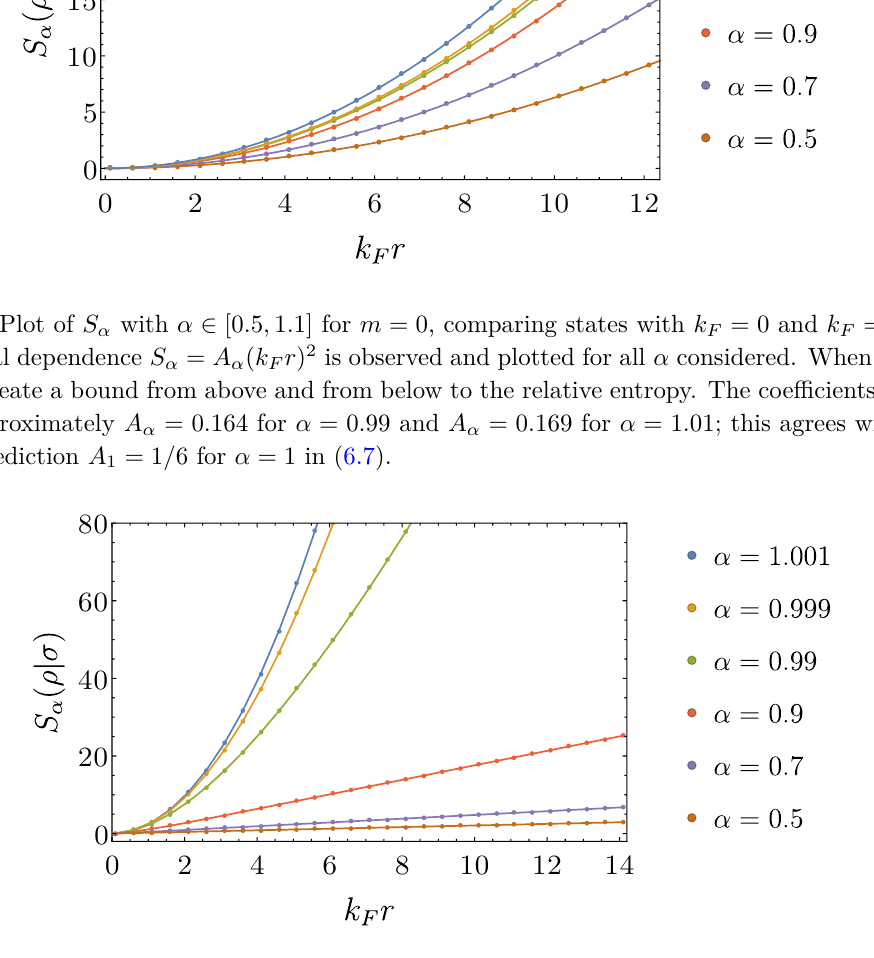
Figure 10 . Plot for the relative Renyi entropies with α ∈ [0 . 5 , 1 . 1] for k F = 1 / 20 and comparing states with m = 0 and m = 1 / 10 . The curves scale like ∼ ( k F r ) 2 for small k F r , but higher powers also arise for larger